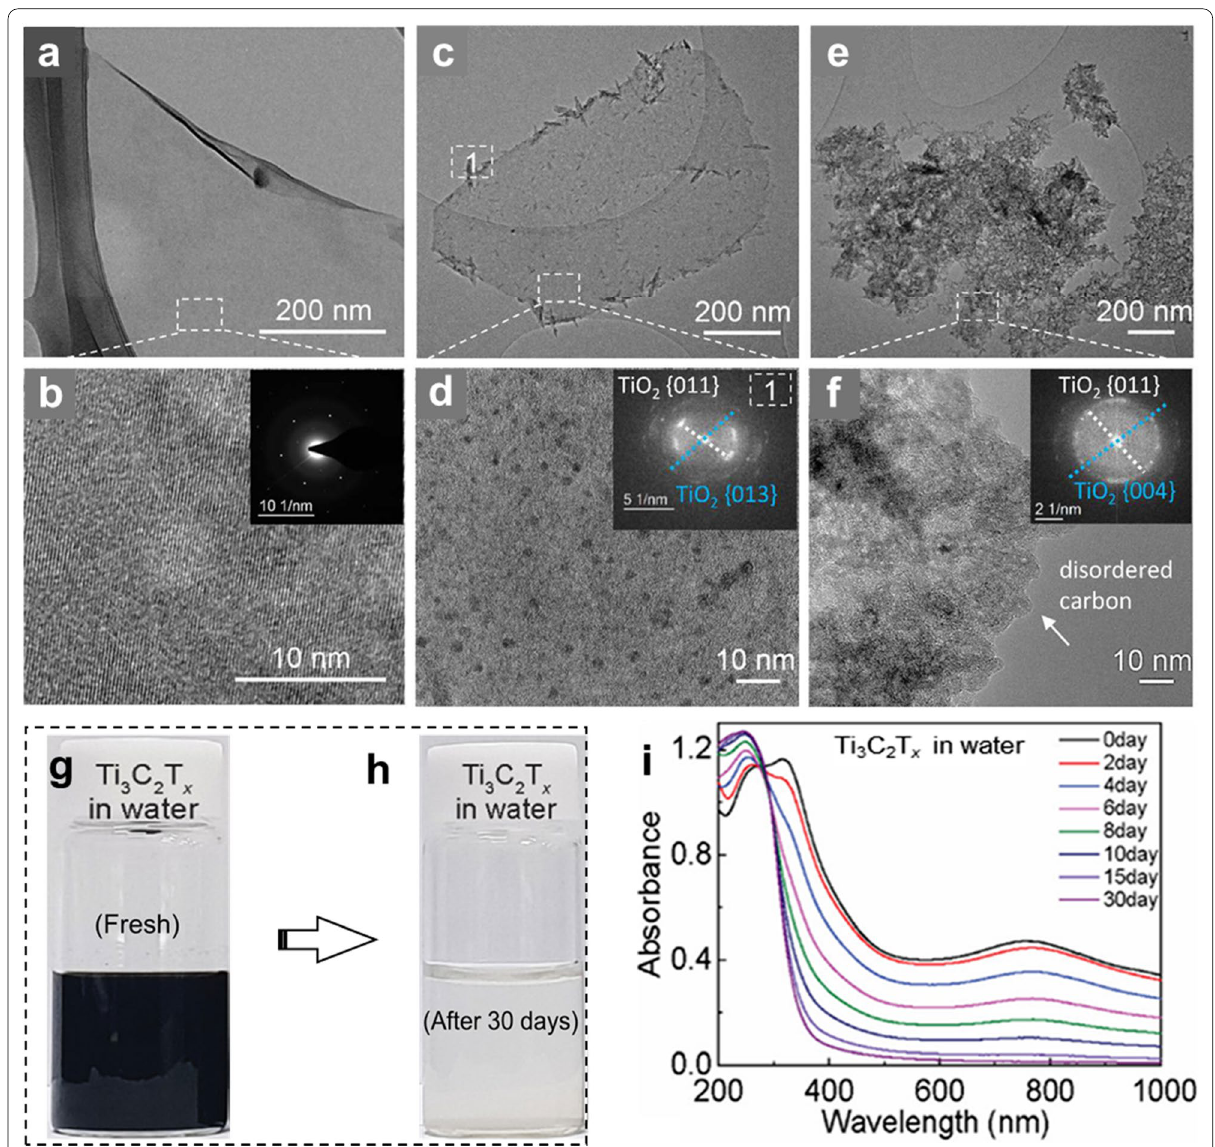
Fig. 2 TEM images of a MXene flakes from fresh d-Ti 3 C 2 T x solution and aged solutions in open air for c 7 days and e 30 days, respectively. b , d , f The high-resolution TEM images of a , c , e ; respectively. Inset in b is the corresponding Selected Area Electron Diffraction (SAED) pattern, and those in d , f are the corresponding FFT patterns. g , h Photographs of fresh Ti 3 C 2 T x MXene in water, and the aged Ti 3 C 2 T x MXene dispersion in water after 30 days in open air, showing an opaque whitish color due to oxidation. i UV–visible absorbance spectra of pristine Ti 3 C 2 T x in water collected over a period of one month. a – f Reproduced with permissions from ref. [41]. Copyright (2017), American Chemical Society. g – i Reproduced with permissions from ref. [40]. Copyright (2019), American Chemical